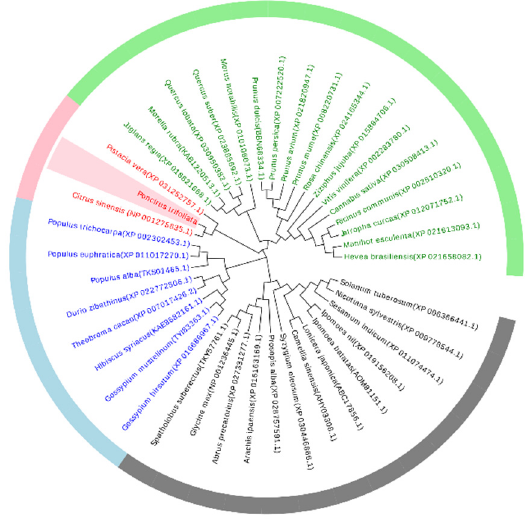
Figure 1. Phylogenetic analysis of allene oxide synthase (AOS) proteins among trifoliate orange and other plant species. The phylogenetic tree was constructed by the neighbor-joining method with 1000 replicates of bootstrap values.